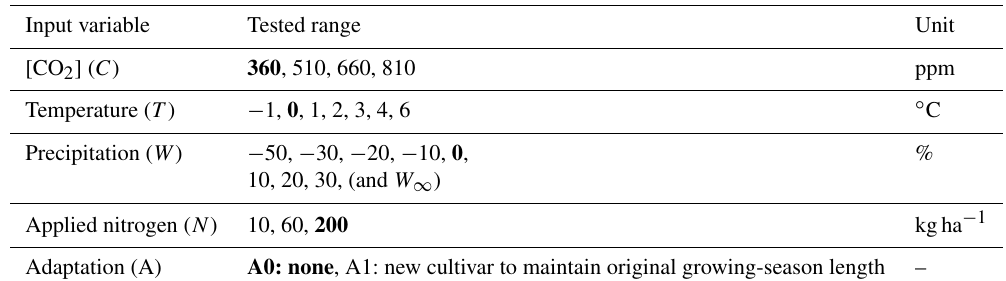
Table 2. GGCMI Phase 2 input levels for the parameter sweep. Values for temperature and water supply are perturbations from the historical climatology. For water supply, perturbations are fractional changes to historical precipitation, except in the irrigated ( W ∞ ) simulations, which are all performed with the maximum beneficial levels of water. Bold font indicates the “baseline” historical level. The full protocol samples across all parameter combinations for a total of 756 cases. Table is repeated from Franke et al.